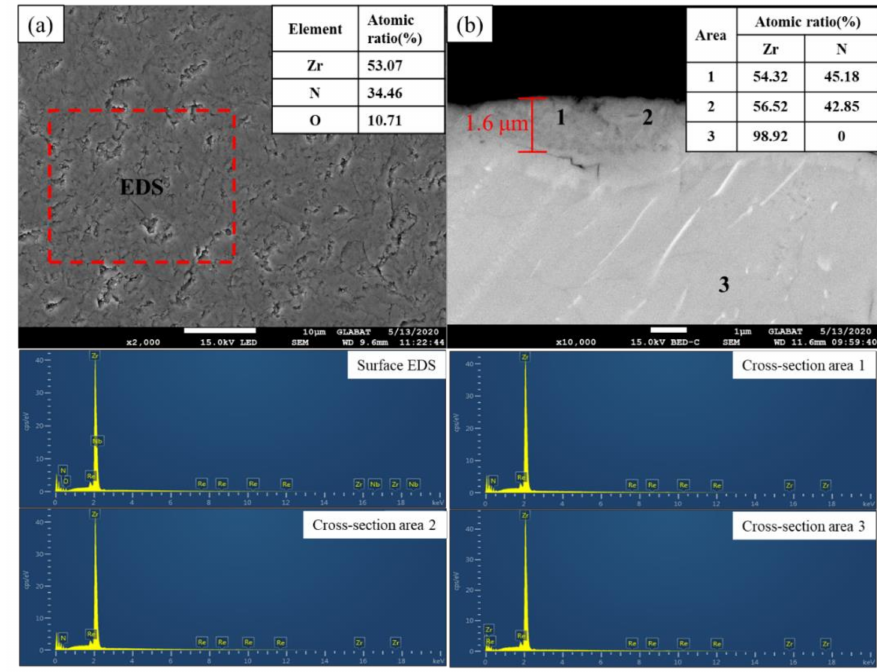
Figure 3. SEM images of the films: ( a ) surface morphology; ( b ) cross-section